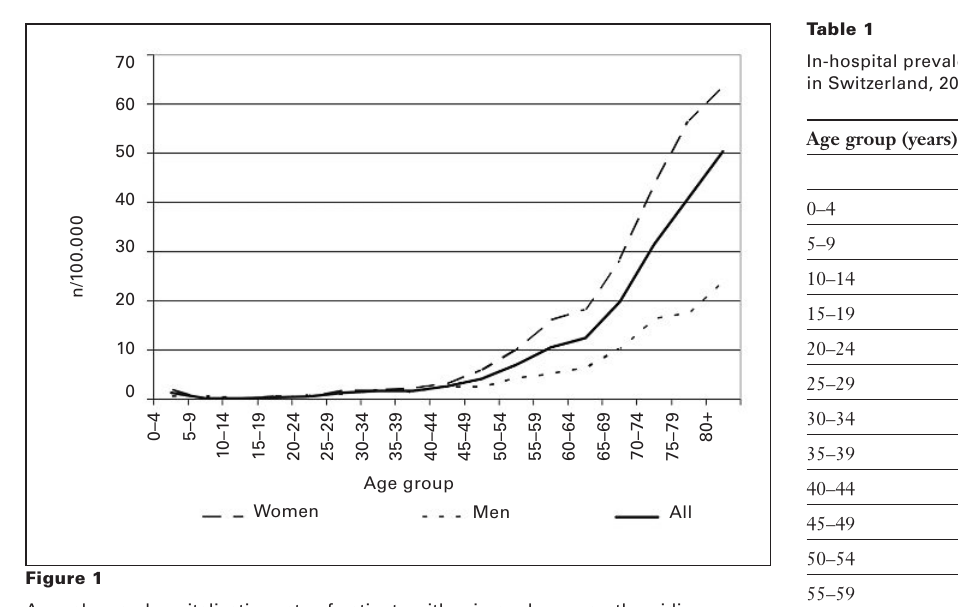
Annual mean hospitalisation rate of patients with primary hyperparathyroidism per 100,000 inhabitants in Switzerland,